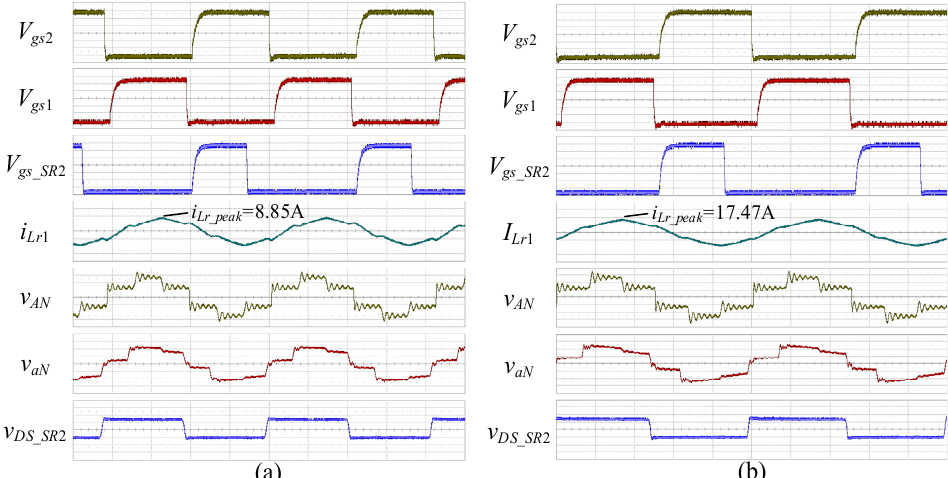
Figure 21. ( a ) Experiment waveform at 50% load ( b ) Experiment waveform at 100% load. (Time: 2 µ s/div; Vgs 1: 2 V/div; Vgs 2: 2 V/div; Vgs_SR 2: 2 V/div). (( a ) i Lr 1 : 5 A/div; ( b ) i Lr 1 : 10 A/div; v AN : 100 V/div; v aN : 100 V/div; v DS_SR 2 : 20